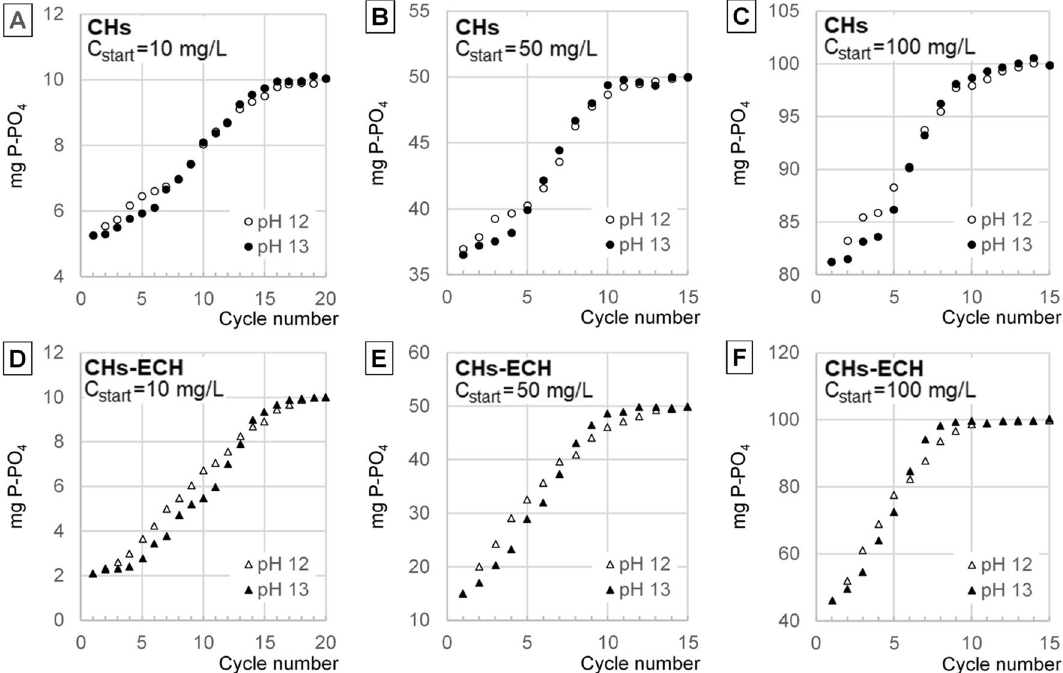
Figure 5. Concentrations of i-PO4 in source solutions (C start = 10–100 mg P-PO 4 /L) after sorption in the successive cycles using CHs and CHs-ECH : ( A ) CHs, C start = 10 mg P-PO 4 /L, ( B ) CHs, C start = 50 mg P-PO 4 /L, ( C ) CHs, C start = 100 mg P-PO 4 /L, ( D ) CHs-ECH, C start = 10 mg P-PO 4 /L, ( E ) CHs-ECH, C start = 50 mg P-PO 4 /L, ( F ) CHs-ECH, C start = 100 mg P-PO 4 /L. (Sorbent dose = 1 g d.m. /L, sorption in pH 4 for CHs and pH 3 for CHs- ECH, desorption at pH 12 and 13, 150 r.p.m., temp. 22